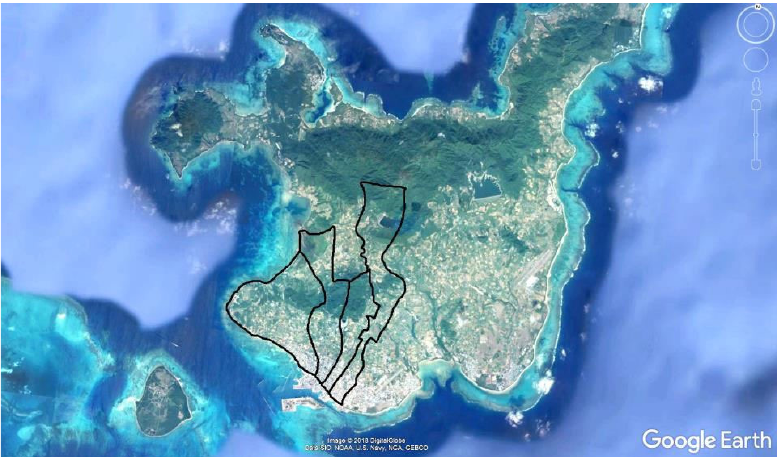
Figure 2. Shik ā zaarea of Ishigaki 8 (Topping 2018). Figure 2. Shik¯azaarea of Ishigaki 8 (Topping